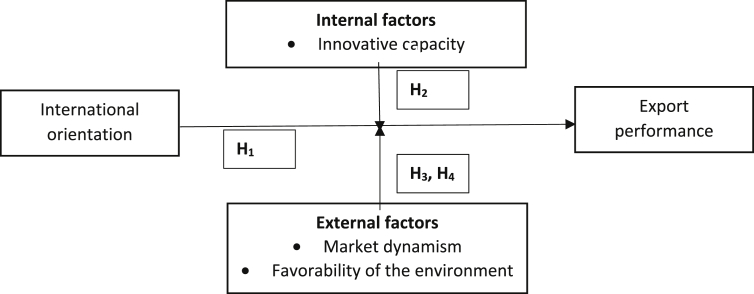
Conceptual model.